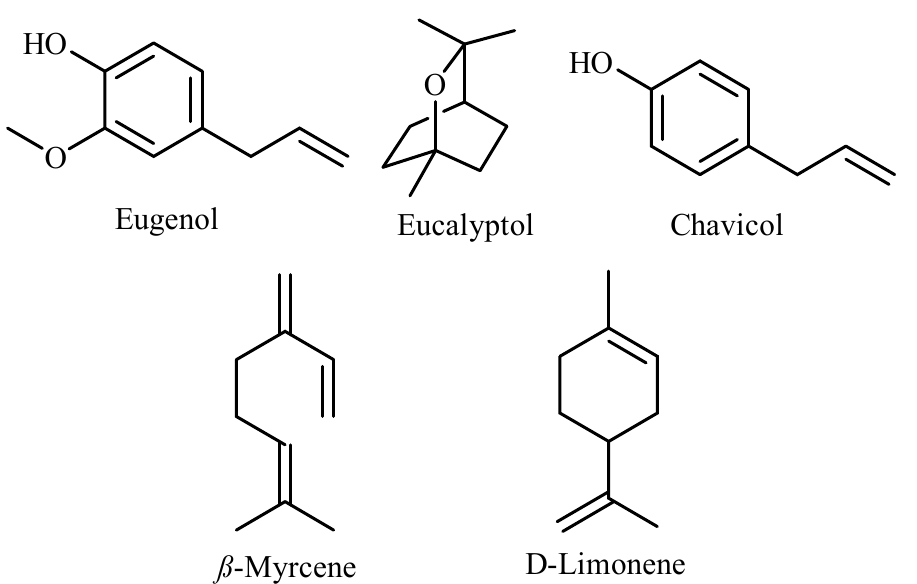
Figure 1. GC-MS chromatograms of P. racemosa leaf ( A ) and stem ( B ) essential oils on the Rtx-5MS column.